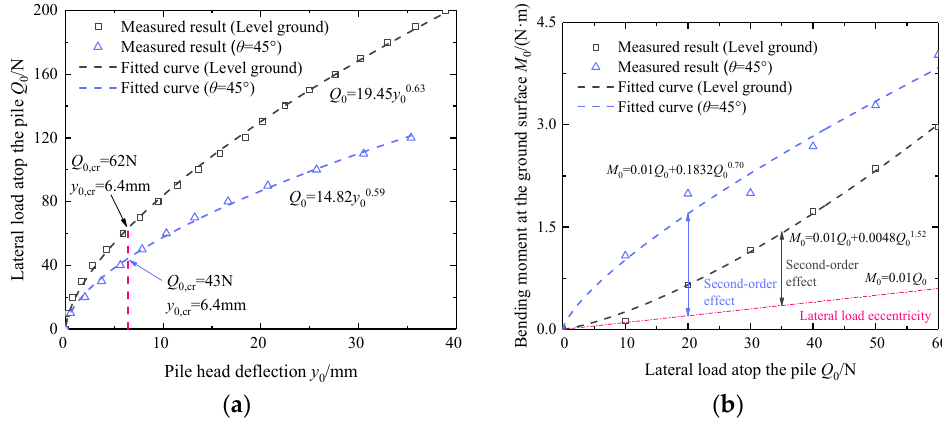
Figure 6. Developments of pile responses with lateral load in lateral static loading tests. ( a ) Q 0 versus y 0 ; ( b ) M 0 versus Q 0 .